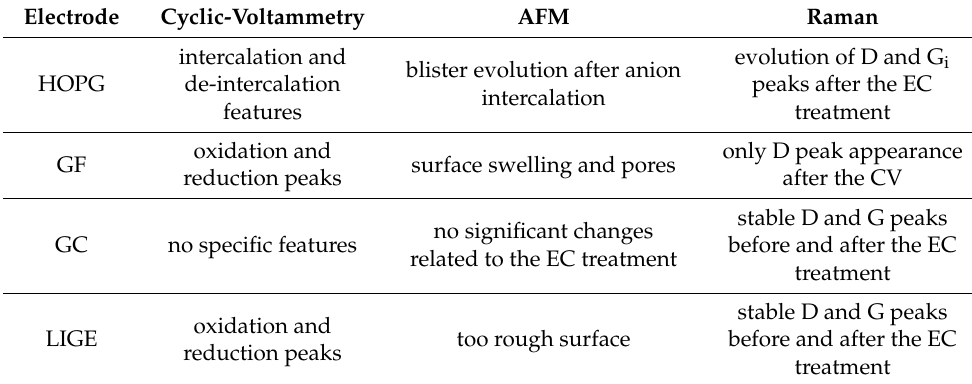
Table 1. Comparison table between HOPG, GF, GC and LIGE